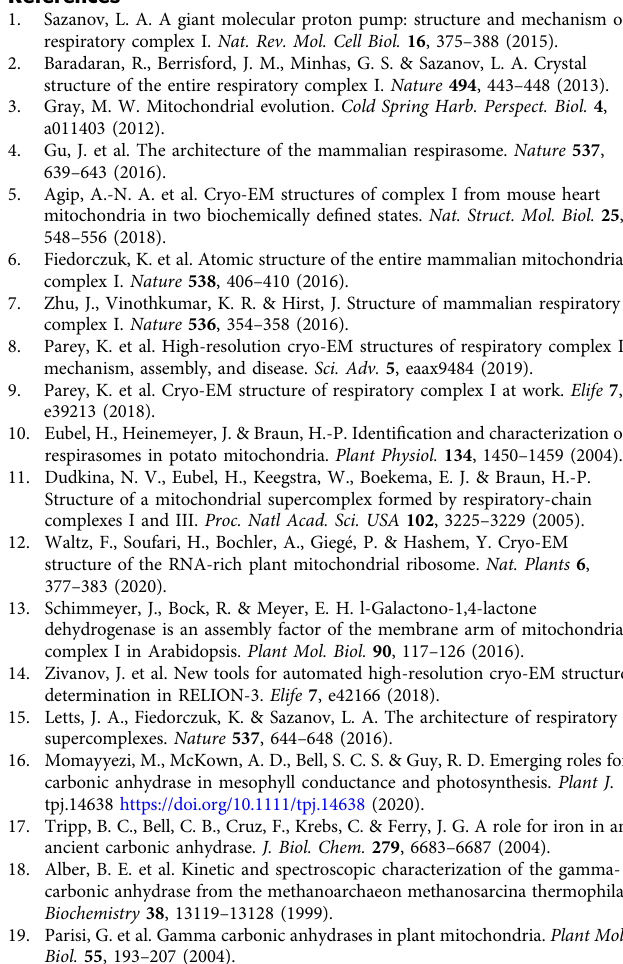
Figure preparation . Figures featuring cryo-EM densities, as well as atomic models were visualized with UCSF ChimeraX 43 and Chimera 39 . Reporting summary . Further information on research design is available in the Nature Research Reporting Summary linked to this article. Data availability The cryo-EM maps of plant mitochondrial complex I have been deposited at the Electron Microscopy Data Bank (EMDB): EMD-11614 for the mature complex, EMD-11513 for the focused reconstruction, EMD-11615 for the assembly intermediate. The corresponding atomic models been deposited in the Protein Data Bank (PDB) under the accession 7A23 for the mature complex and 7A24 for the assembly intermediate. Mass spectrometric data have been deposited to the ProteomeXchange Consortium via